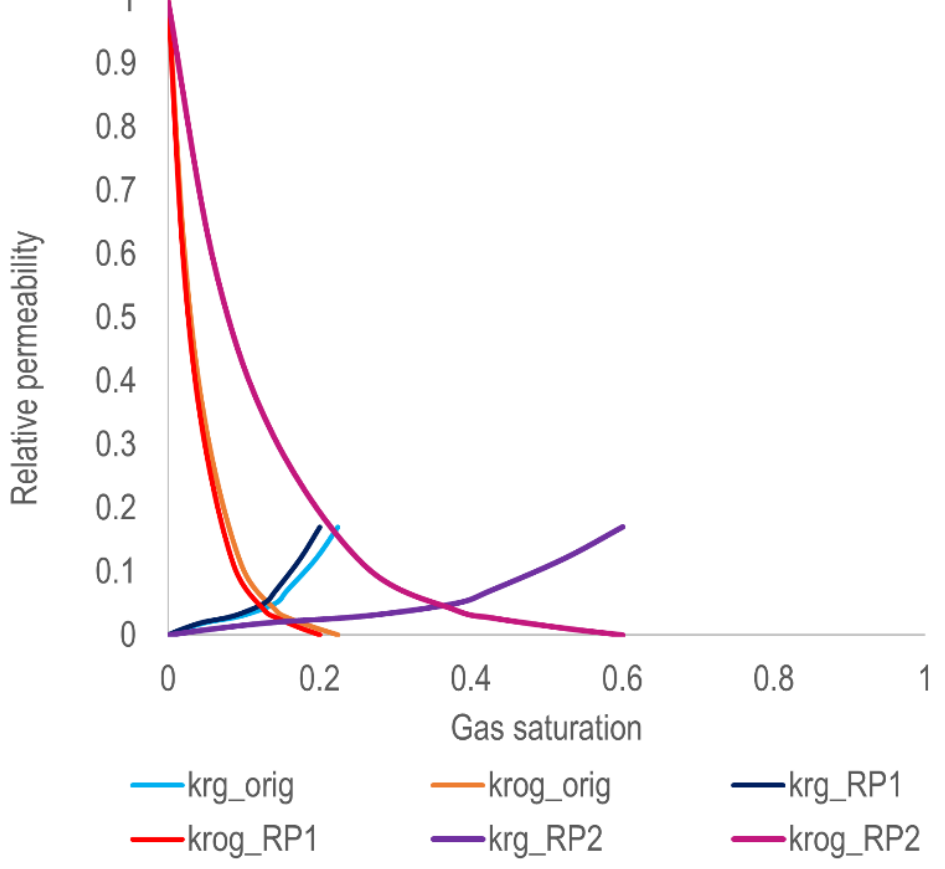
Figure 5. Effect of relative permeability curves on cumulative oil production, simulation results.